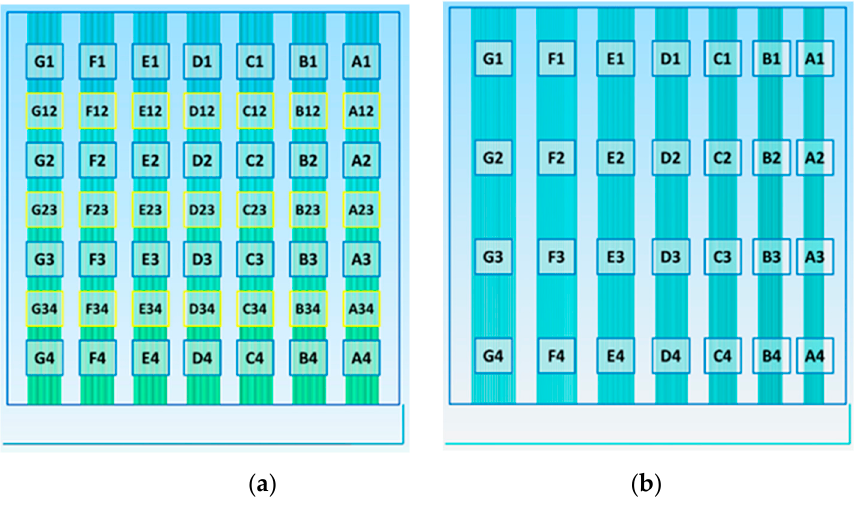
Figure 4. Methodology for image capturing of regions of interest: ( a ) overview of custom G ‐ code motion and pauses; ( b ) central regions of interest; ( c ) boundary edge regions of interest.